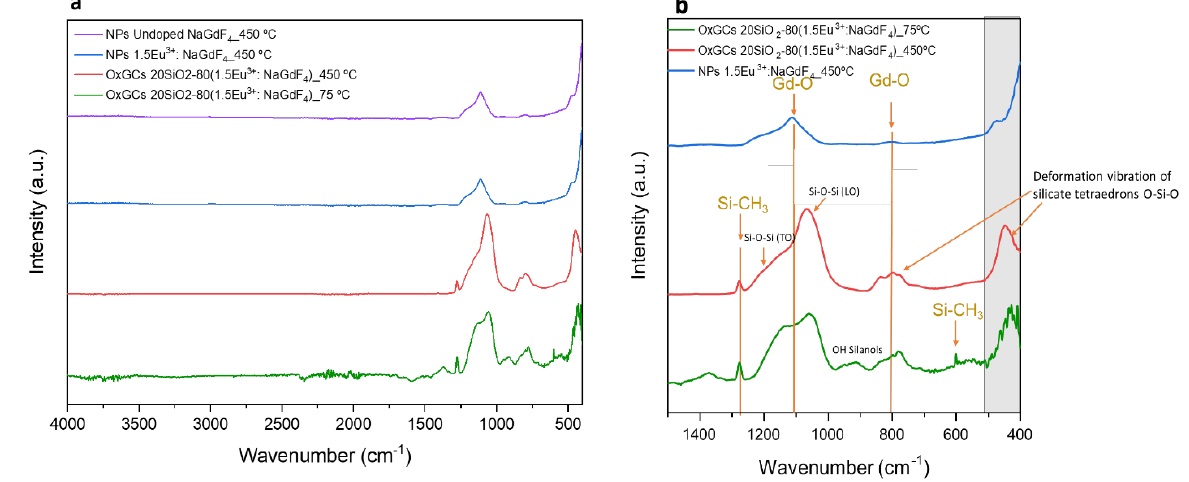
Figure 4. ( a ) FTIR spectra from 4000 cm −1 to 450 cm −1 of undoped NaGdF 4 NPs, 1.5Eu 3+ : NaGdF 4 NPs (violet and blue line, respectively) and OxGCs with the composition 80SiO 2 -20(1.5Eu 3+ : NaGdF 4 ) dried overnight at 75 °C and heat-treated at 450 °C for 5 h (red and green line, respectively) and ( b ) FTIR spectra recorded from 1500 to 400 cm −1 of 1.5Eu 3+ : NaGdF 4 NPs and 80SiO 2 -20(1.5Eu 3+ : NaGdF 4 ) OxGCs with the composition (blue, red and green line, respectively).